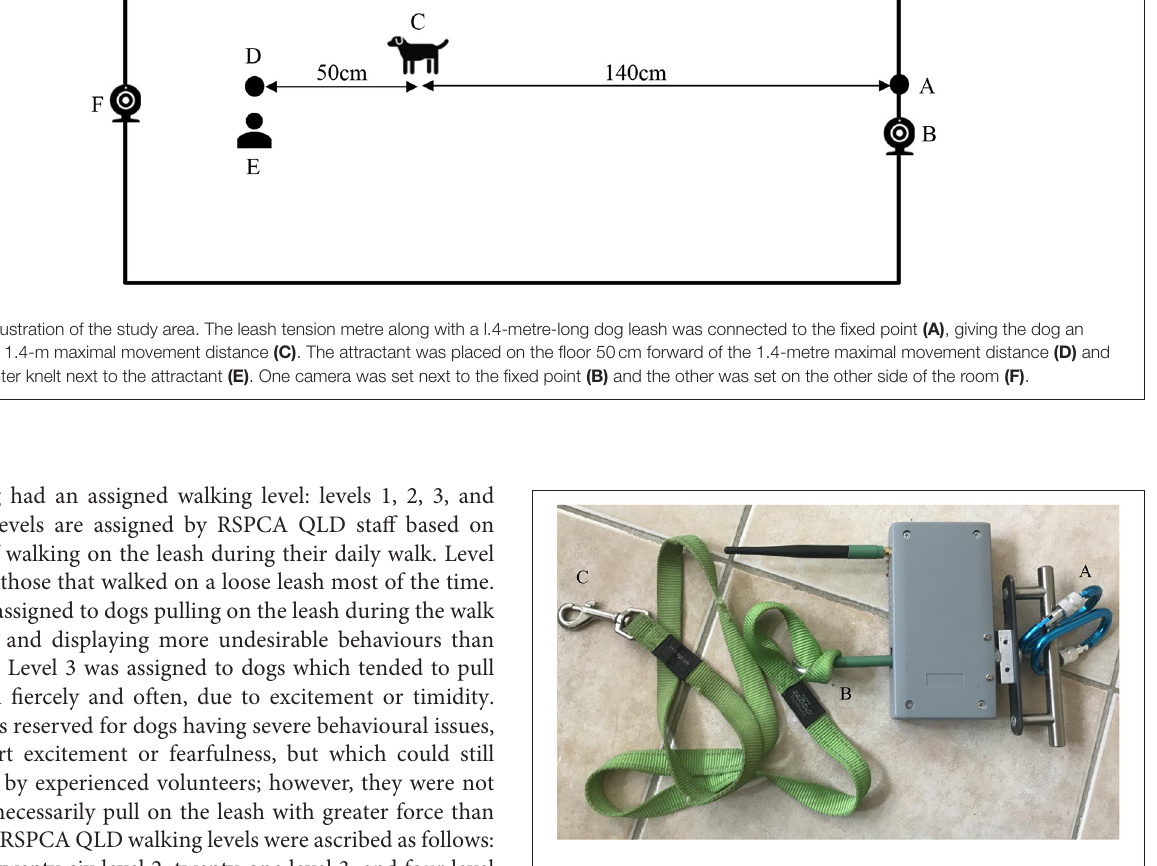
FIGURE 3 | Demonstration of the leash tension metre. One end of the leash tension metre was connected to the tie-up ring using two carabiners (A) . On the other end of the device was a stainless-steel eyebolt to allow a simple connexion with a l.4-m-long commercial dog leash (B) , and the leash would be connected to the dog (C)